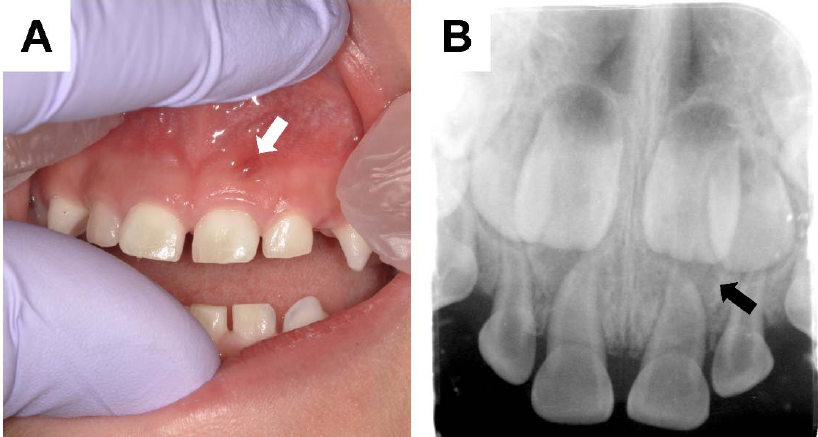
Figure 1. Clinical and radiographic dental manifestations of X-linked hypophosphatemia (XLH). ( A ) Oral photograph of male patient aged 4 years 4 months showing a periapical gingival abscess (white arrow) corresponding to the primary maxillary left central incisor. ( B ) Periapical radiograph showing radiolucency (black arrow) around the periapical region of the primary maxillary left central